Question: What type of chart is this?
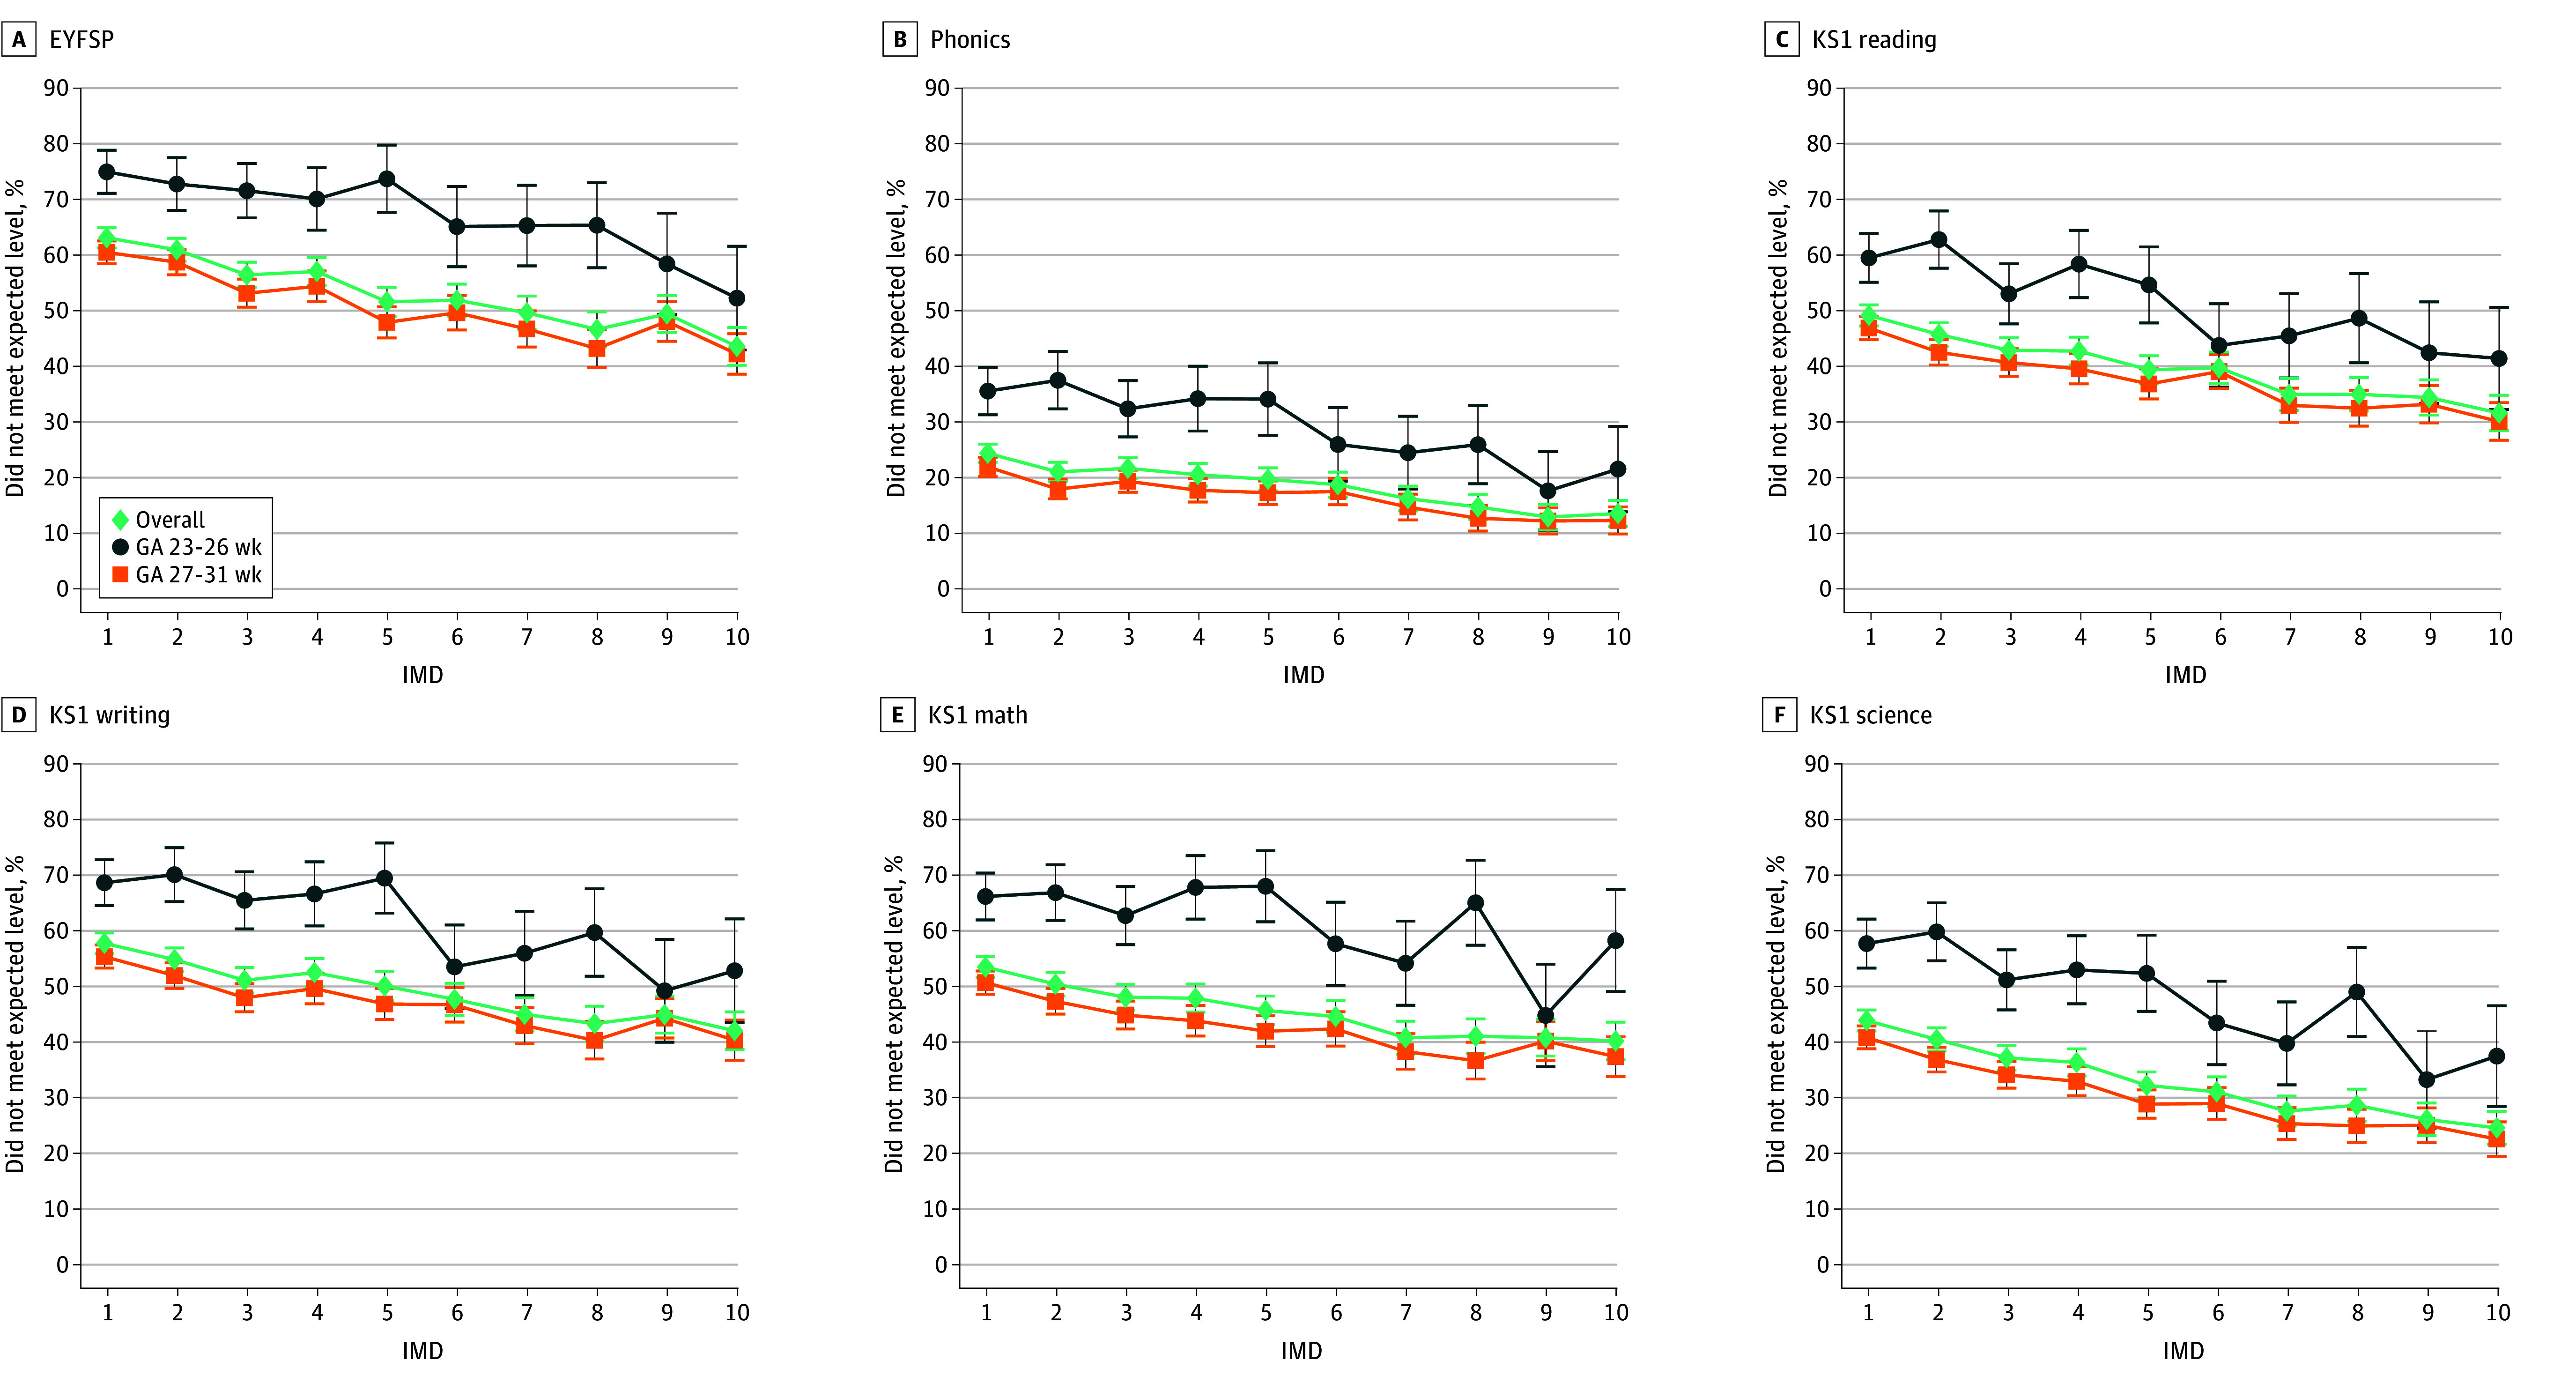
Answer: bar